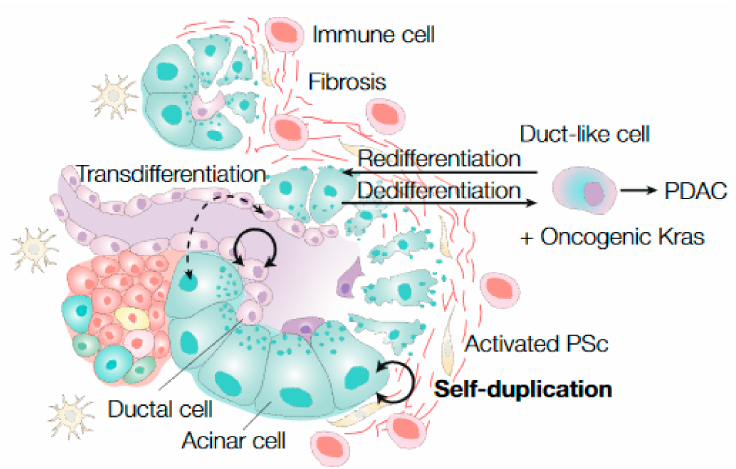
Figure 2. Stem cell dynamics in the exocrine pancreas during injury. After injury induction, the pancreas becomes fibrotic, immune cells infiltrate, pancreatic stellate cells (PSc) become activated, and the cellular differentiation state of exocrine pancreatic cells (ductal and (centro) acinar cells) becomes more plastic. Cellular replacement of pre-existing exocrine cells (self-duplication), often via dedifferentiation to a more immature state (duct-like cell), is the most important mechanism for pancreatic tissue regeneration upon injury (solid black arrows). Infrequently, after persistent or severe inflammation, mature exocrine pancreatic cells can transdifferentiate into other pancreatic cell types (acinar to ductal cells and vice versa; dashed black arrow). Injury in combination with oncogenic Kras induction in acinar cells can ultimately give rise to initiation of pancreatic ductal adenocarcinoma (PDAC), mostly via pancreatic intraepithelial neoplasia